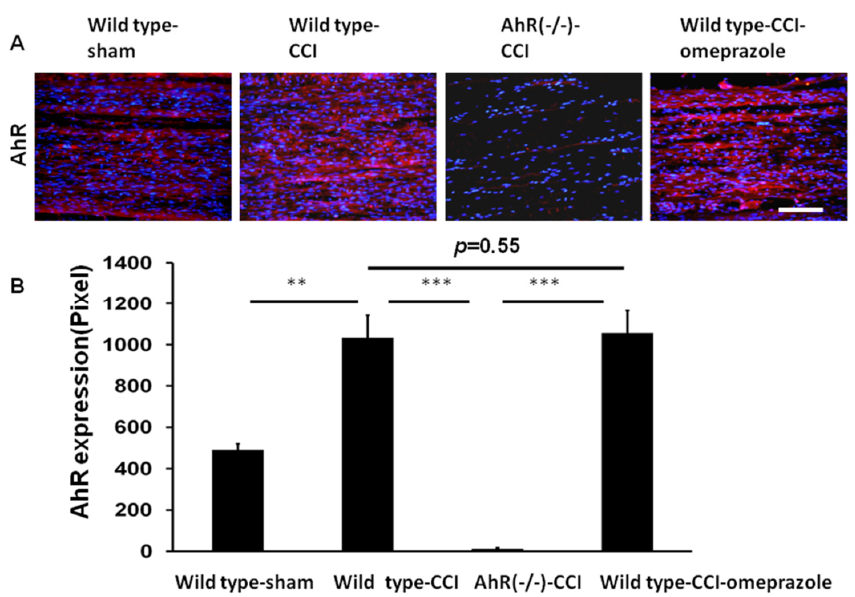
Figure 5. AhR expressions merged with DAPI at the distal end of the nerve 28 days after CCI. ( A ) Expression of AhR in distal end of nerve measured by pixel in the different treatment groups ( B ) The quantitative analysis of AhR expression by pixel in different treatment groups. N = 6, Bar length = 100 µ m. **: p < 0.01; ***: p < 0.001; Wild type-sham; Wild type-CCI; AhR ( − / − )-CCI; Wild type-CCI- omeprazole: see text. Red: AhR; blue: DAPI.